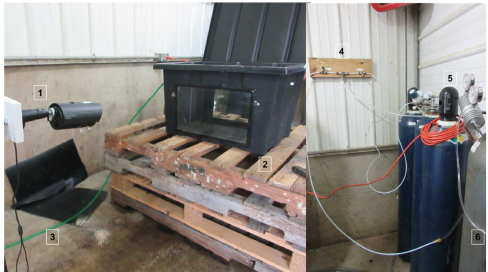
Figure 2. Setup of the gas chamber for Experiment 2. Setup was similar to Experiment 1 except there were two cameras (1) and two acrylic glass observation windows (2). Instead of a ventilator, the vacuum pump created negative pressure and the air it took out was routed through a tube (3) to the outside. The on/off valves (4), tubing, and tanks (5) were similar. However, there was only one tube (6) that went to one mass flow controller and then into the box, instead of two mass flow controllers as was used in experiment